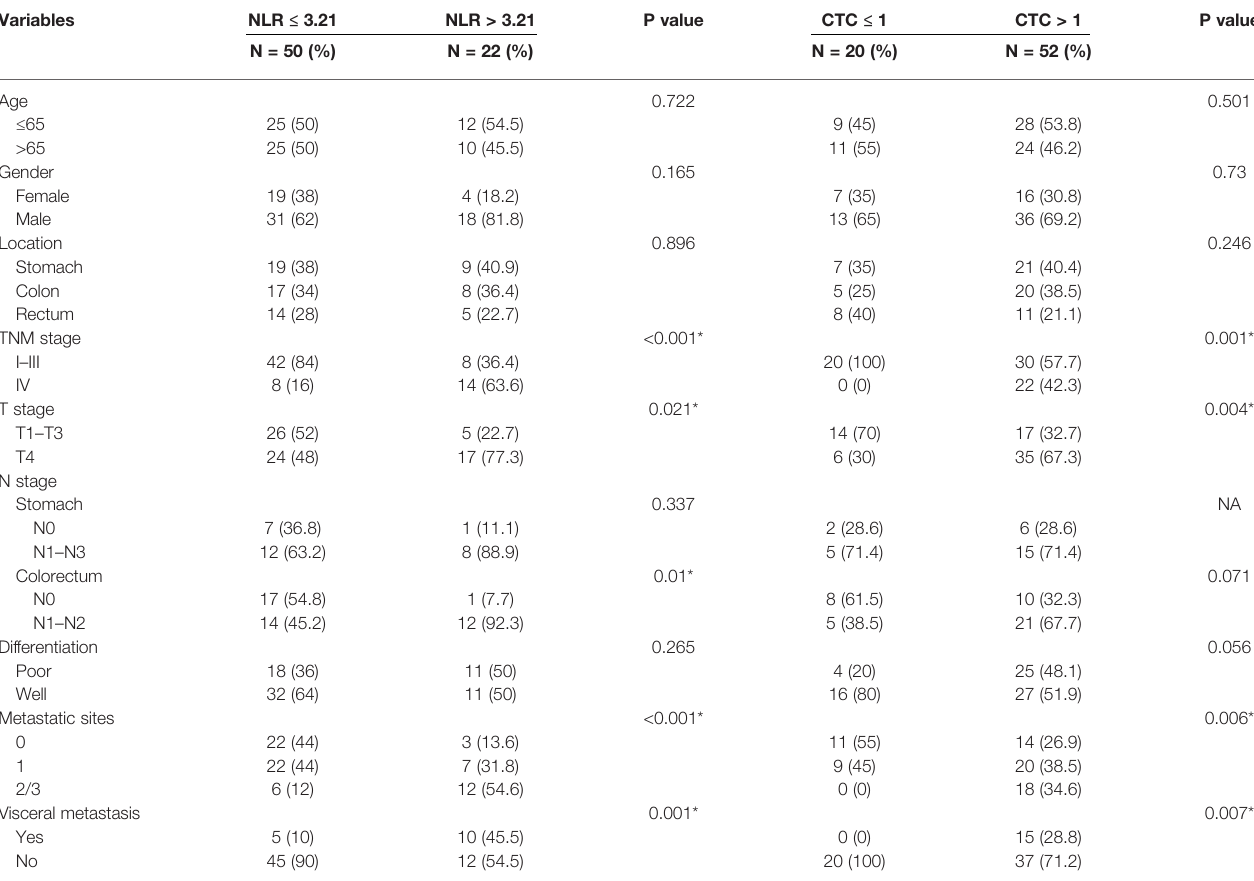
TABLE 2 | Association of NLR (>3.21 versus ≤ 3.21) or CTC (>1 versus ≤ 1) with clinicopathological variables.